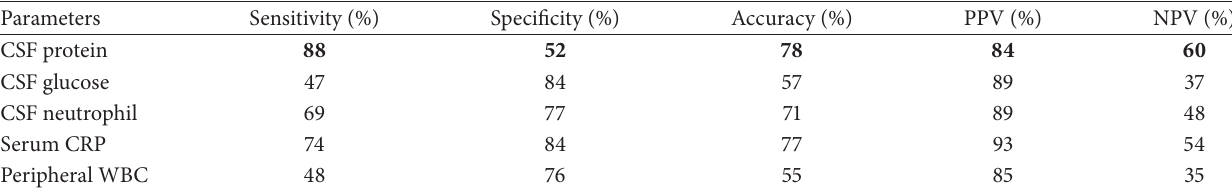
Table 6: Validation of CSF and blood parameters in detecting bacterial